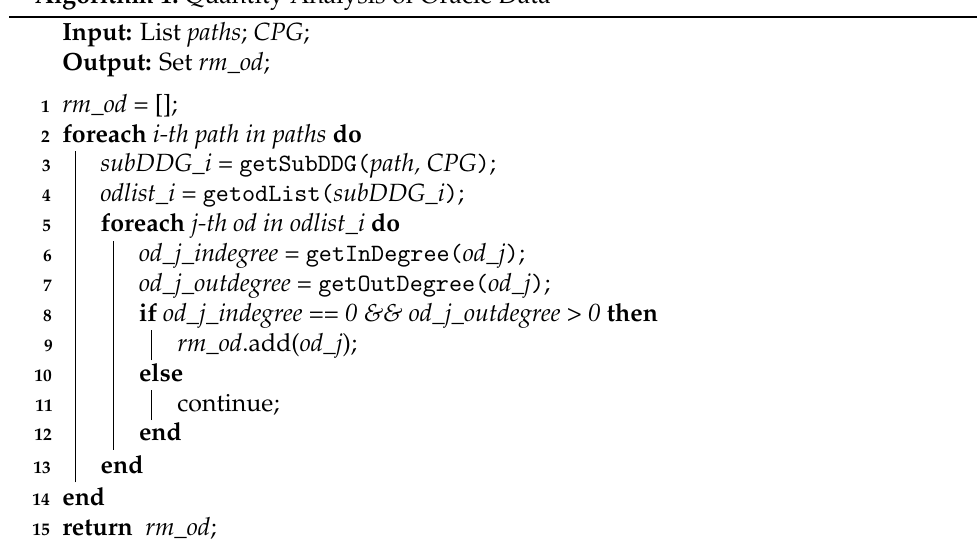
Algorithm 1: Quantity Analysis of Oracle